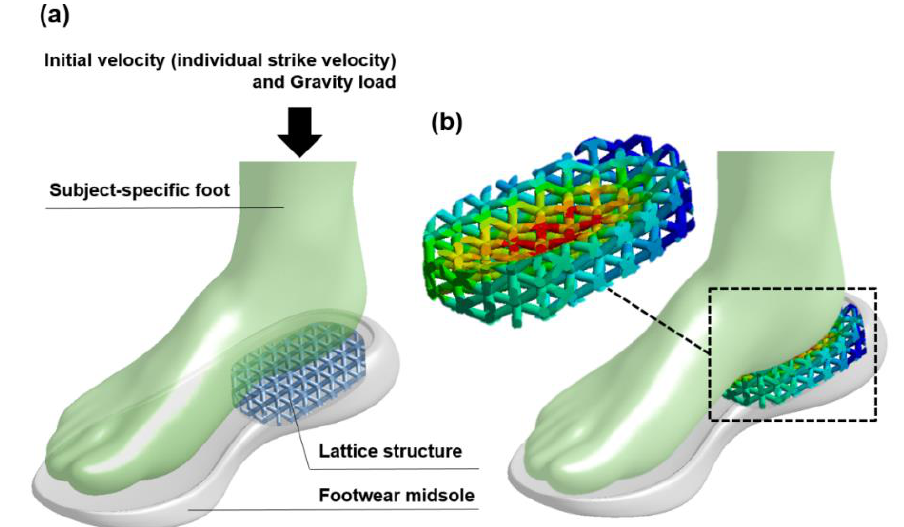
Figure 13. The application of the dynamic impact simulation process on the foot-footwear impact analysis. ( a ) The structure and loading conditions, and the ( b ) lattice structure deformation of the foot-footwear impact analysis.